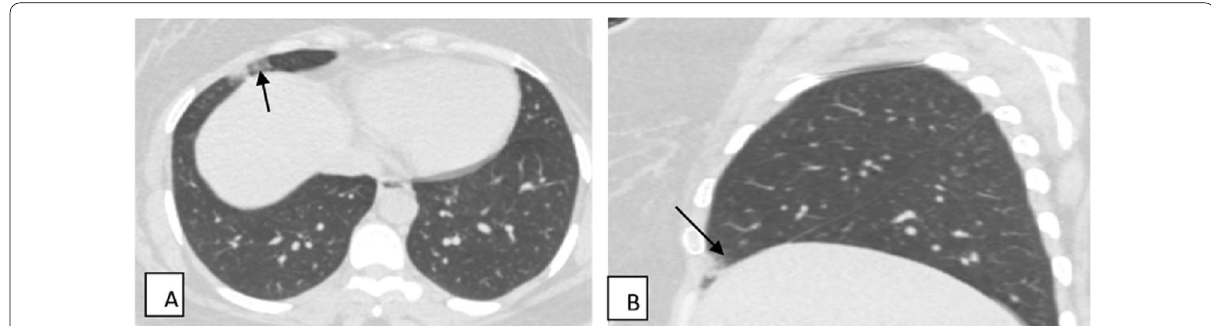
Fig. 4 Female patient aged 34 years old presented by loss of smell and taste only. Axial ( A ) and coronal ( B ) CT cuts show single patchy area of ground‑glass density is seen at right middle lobe (black arrow)